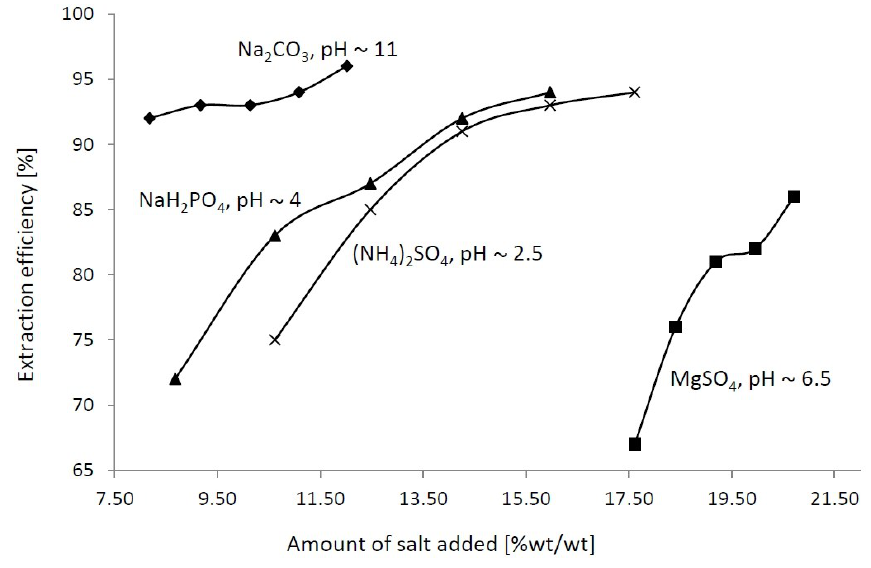
Figure 2. Effect of pH and salt concentration on the partition of glaucine in